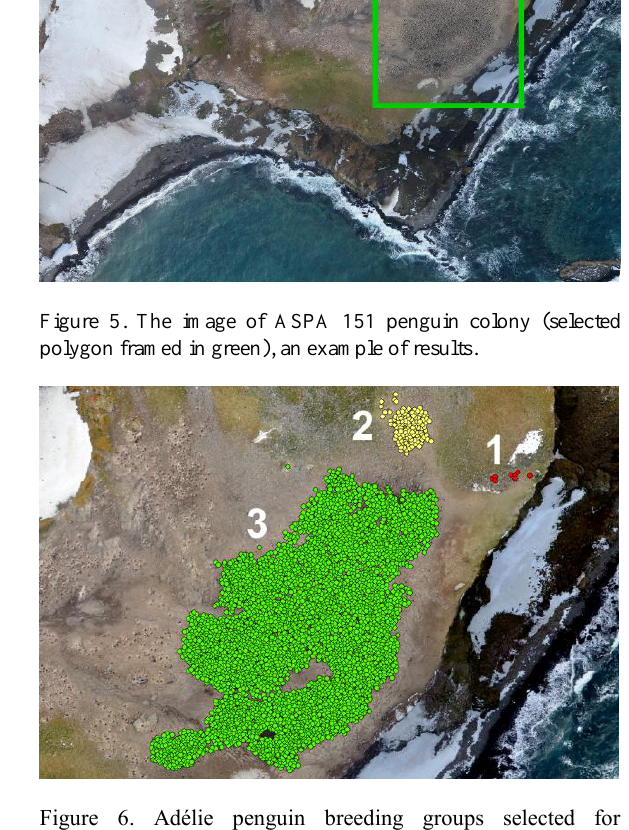
Figure 6. Adélie penguin breeding groups selected for comparison of manual and automatic estimation (ArcMap